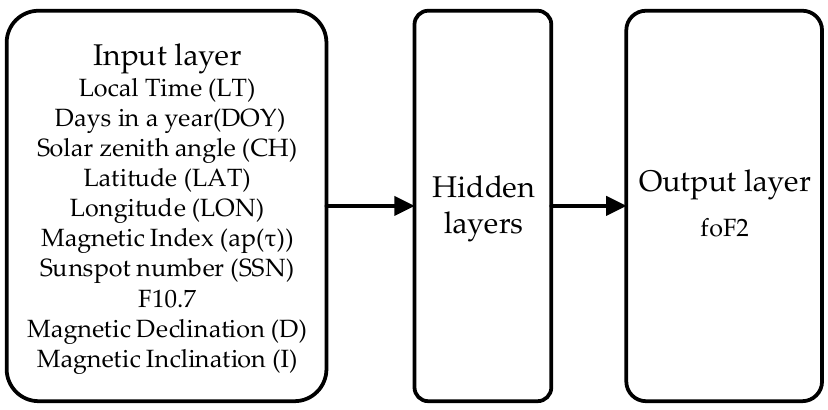
Figure 2. A block diagram of the BPNN and GABP models.